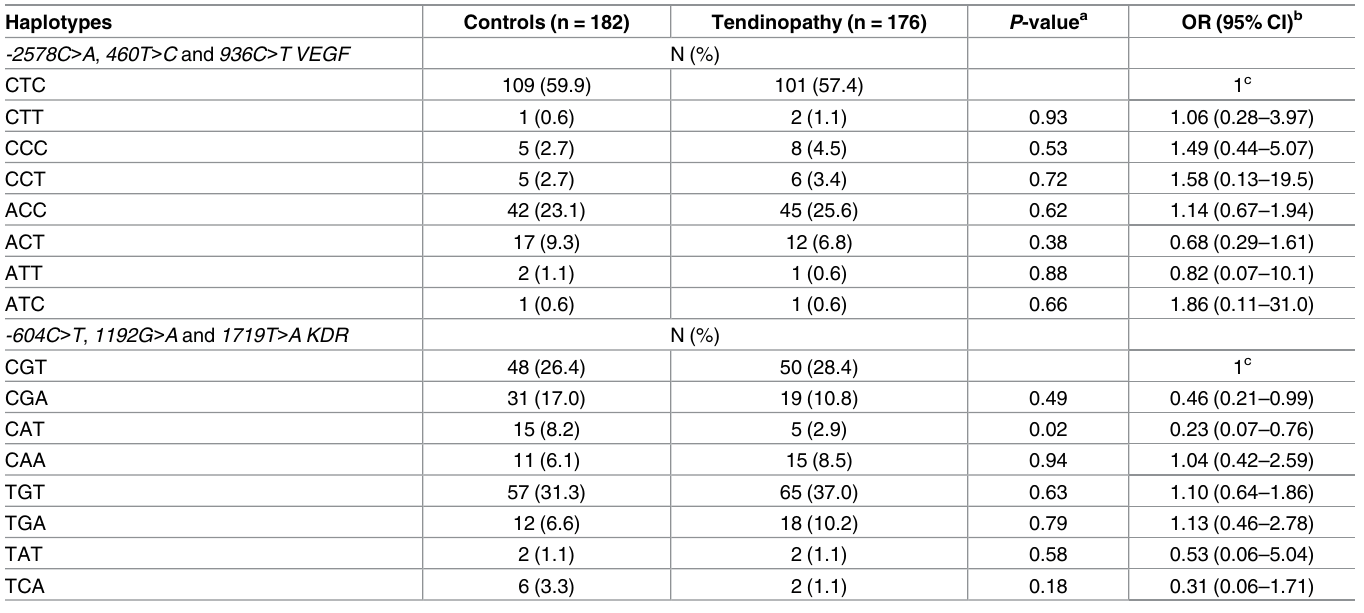
Table 4. Haplotype distributions of VEGF and KDR in volleyball athletes and their association with tendinopathy risk.